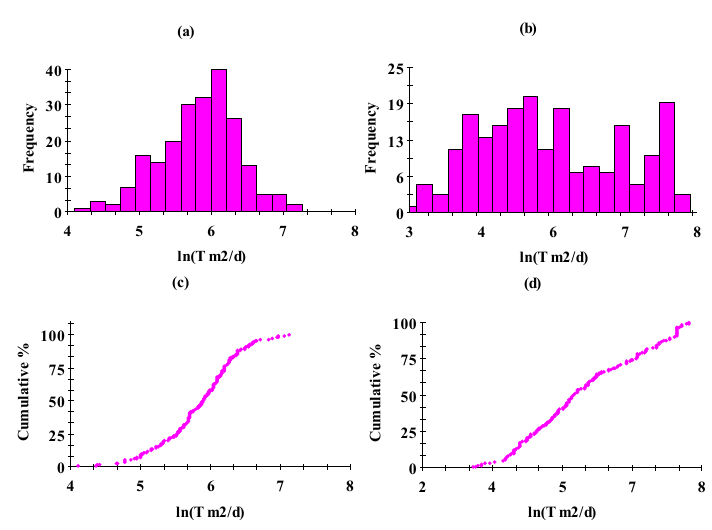
Figure 5. Histogram of the log (T) of the Kg ( a ) and Dm ( b ) and percentage cumulative frequency of Kg ( c ) and Dm ( d ) aquifers.